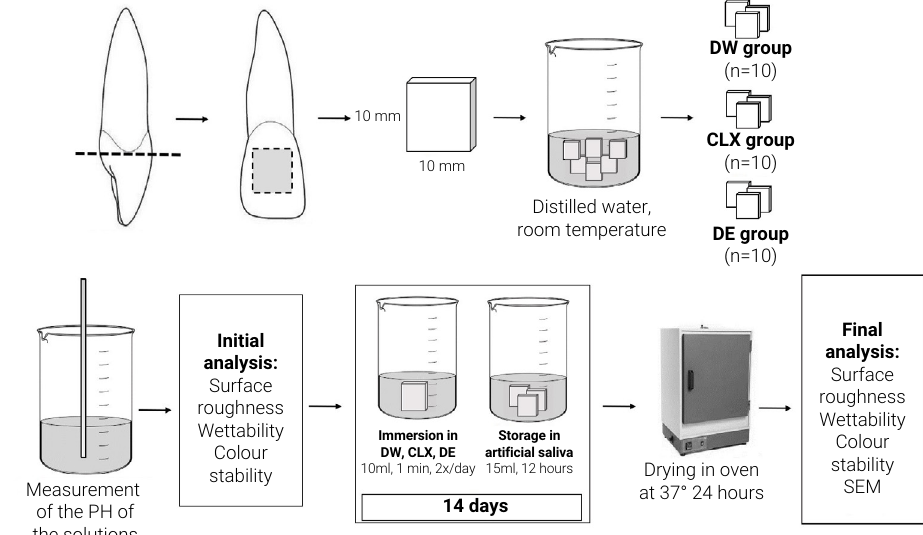
Figure 1. Schematic representation of the